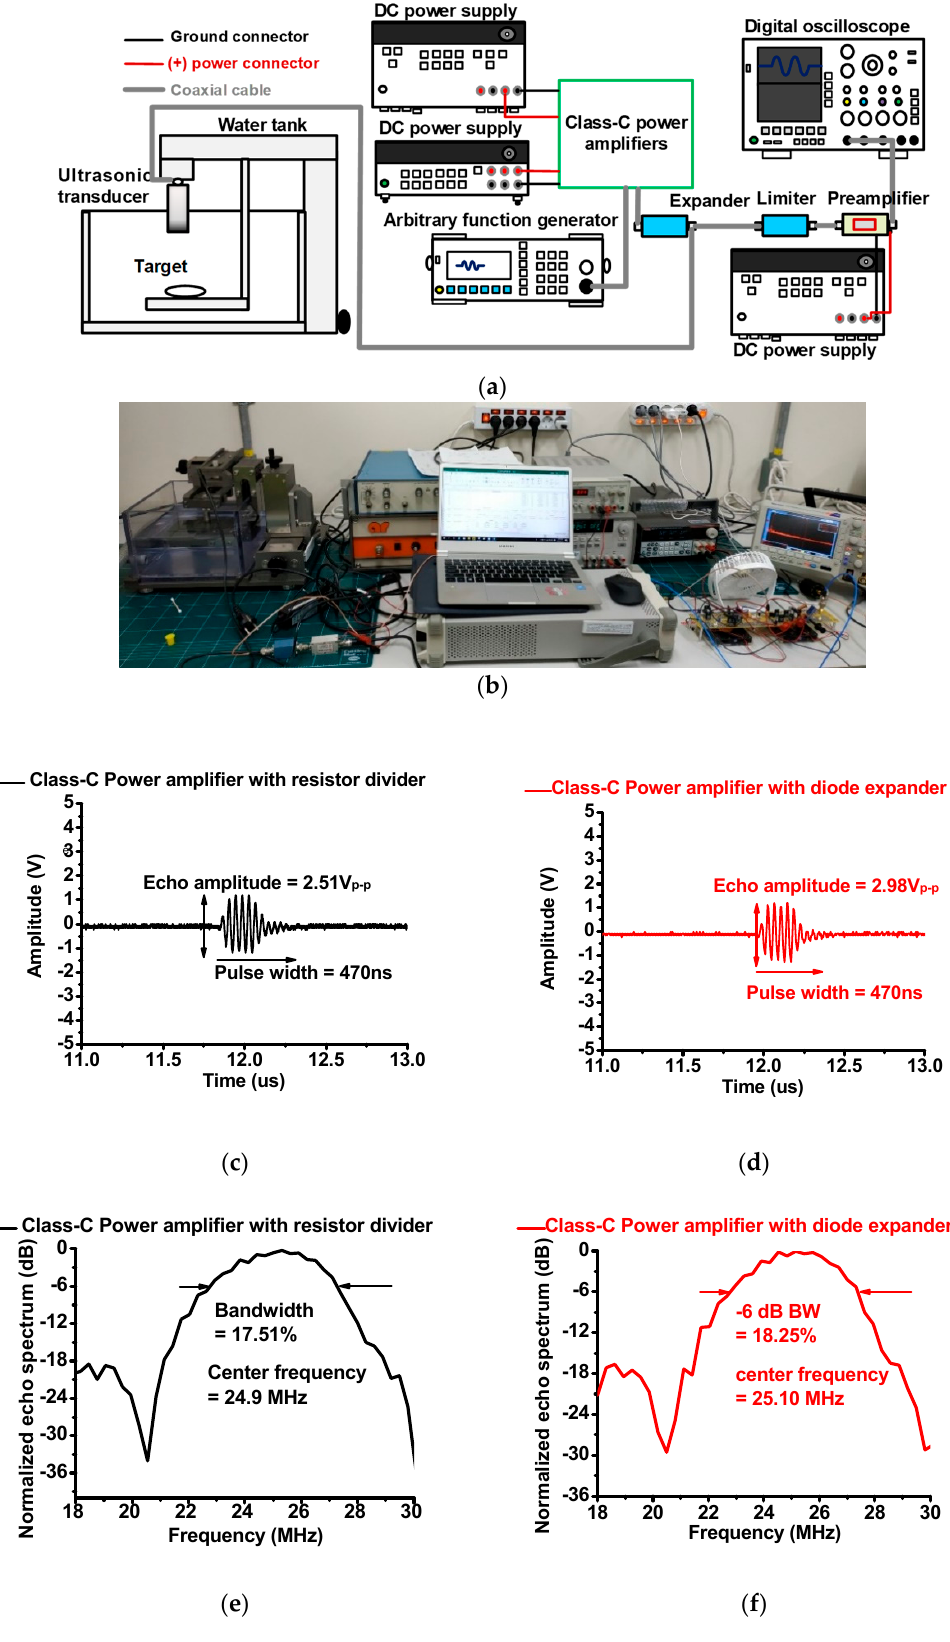
Figure 7. ( a ) Schematic diagram and ( b ) pictures during pulse-echo response measurement; echo signal amplitudes when using the class-C power amplifier with a ( c ) resistor divider and ( d ) diode expander architecture; echo signal spectrums when using the class-C power amplifier with a ( e ) resistor divider and ( f ) diode expander architecture.